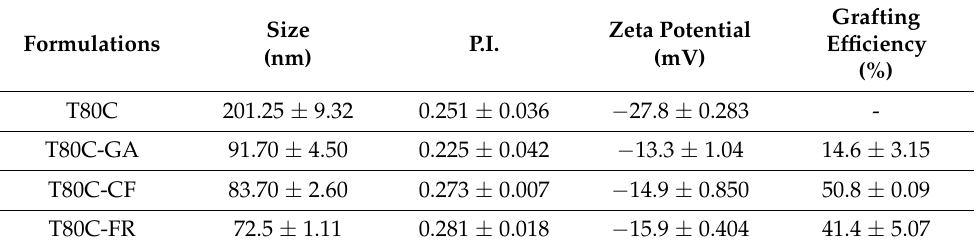
Table 2. Physicochemical properties (hydrodynamic diameter, polydispersity index (P.I.), and zeta potential) of curcumin-loaded niosomes before and after conjugation with phenolic acids at 25 ◦ C. Data represent the mean ± S.D. of three independent experiments performed with triplicate